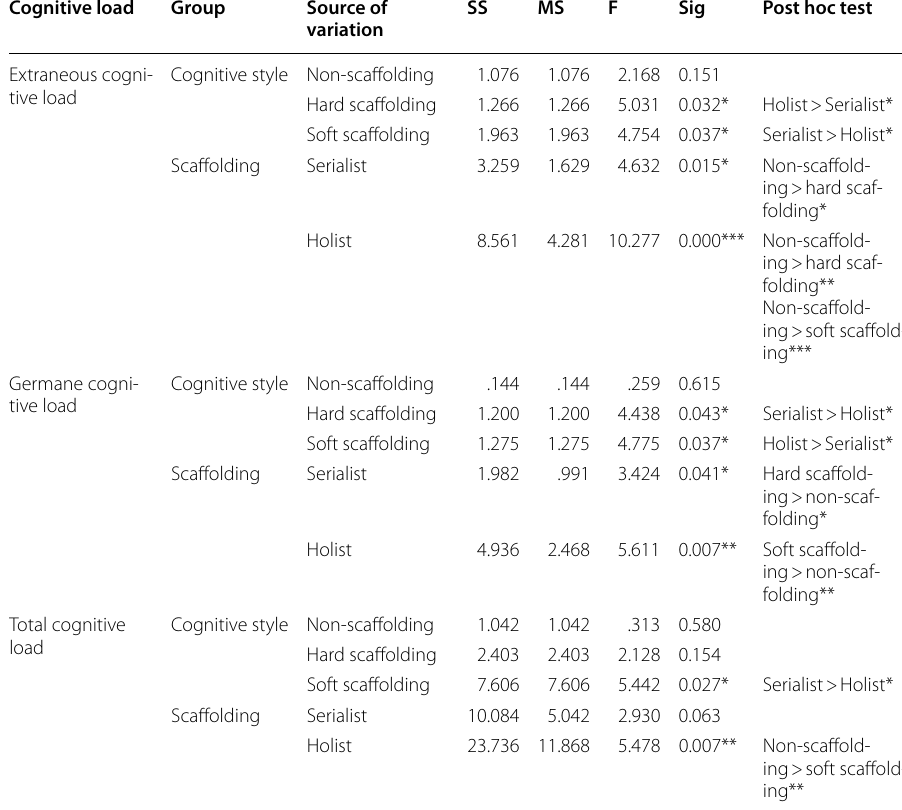
Table 6 Simple main effects of scaffolding DGBLs and cognitive styles on cognitive load Cognitive